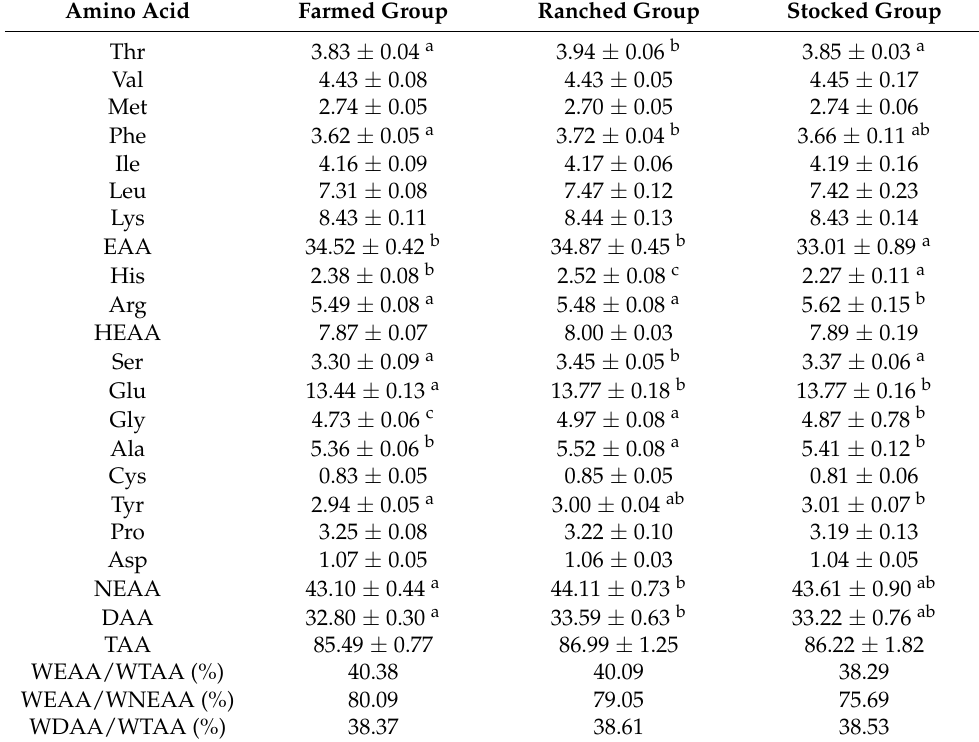
Table 2. Amino acid composition and contents in muscle of three groups (g/100 g, dry sample). Amino Acid Farmed Group Ranched